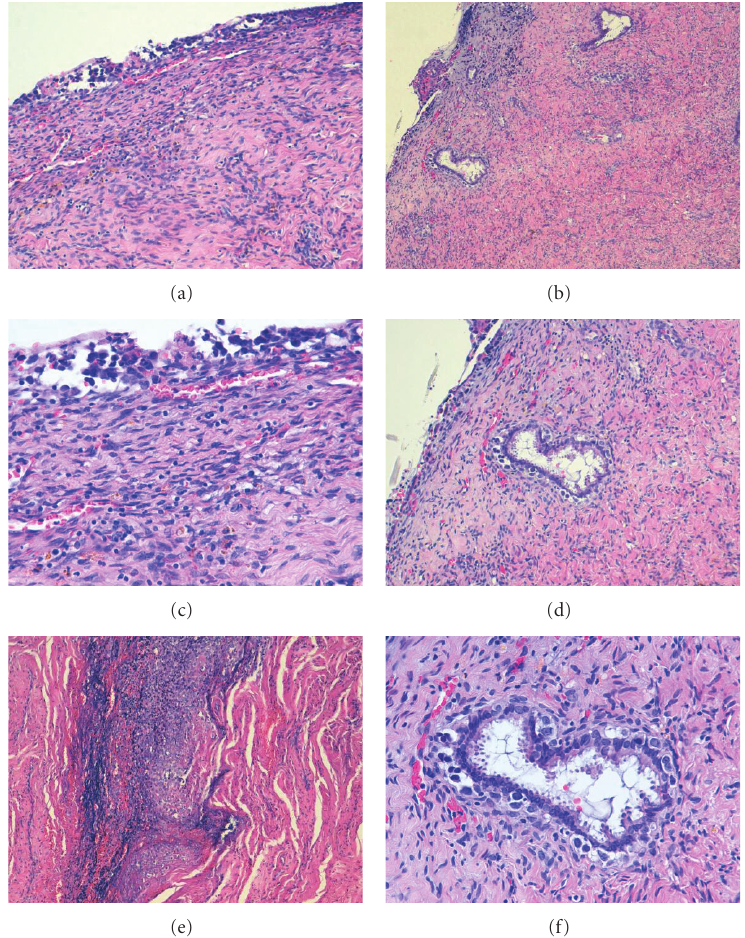
Figure 3: Uterine cervical malignant melanoma. (a, b, c, d, e, and f) Extensive epithelial denudation accompanied of atypical cells. The cells showed an epithelioid appearance. Pagetoid glandular extension and stromal invasion are